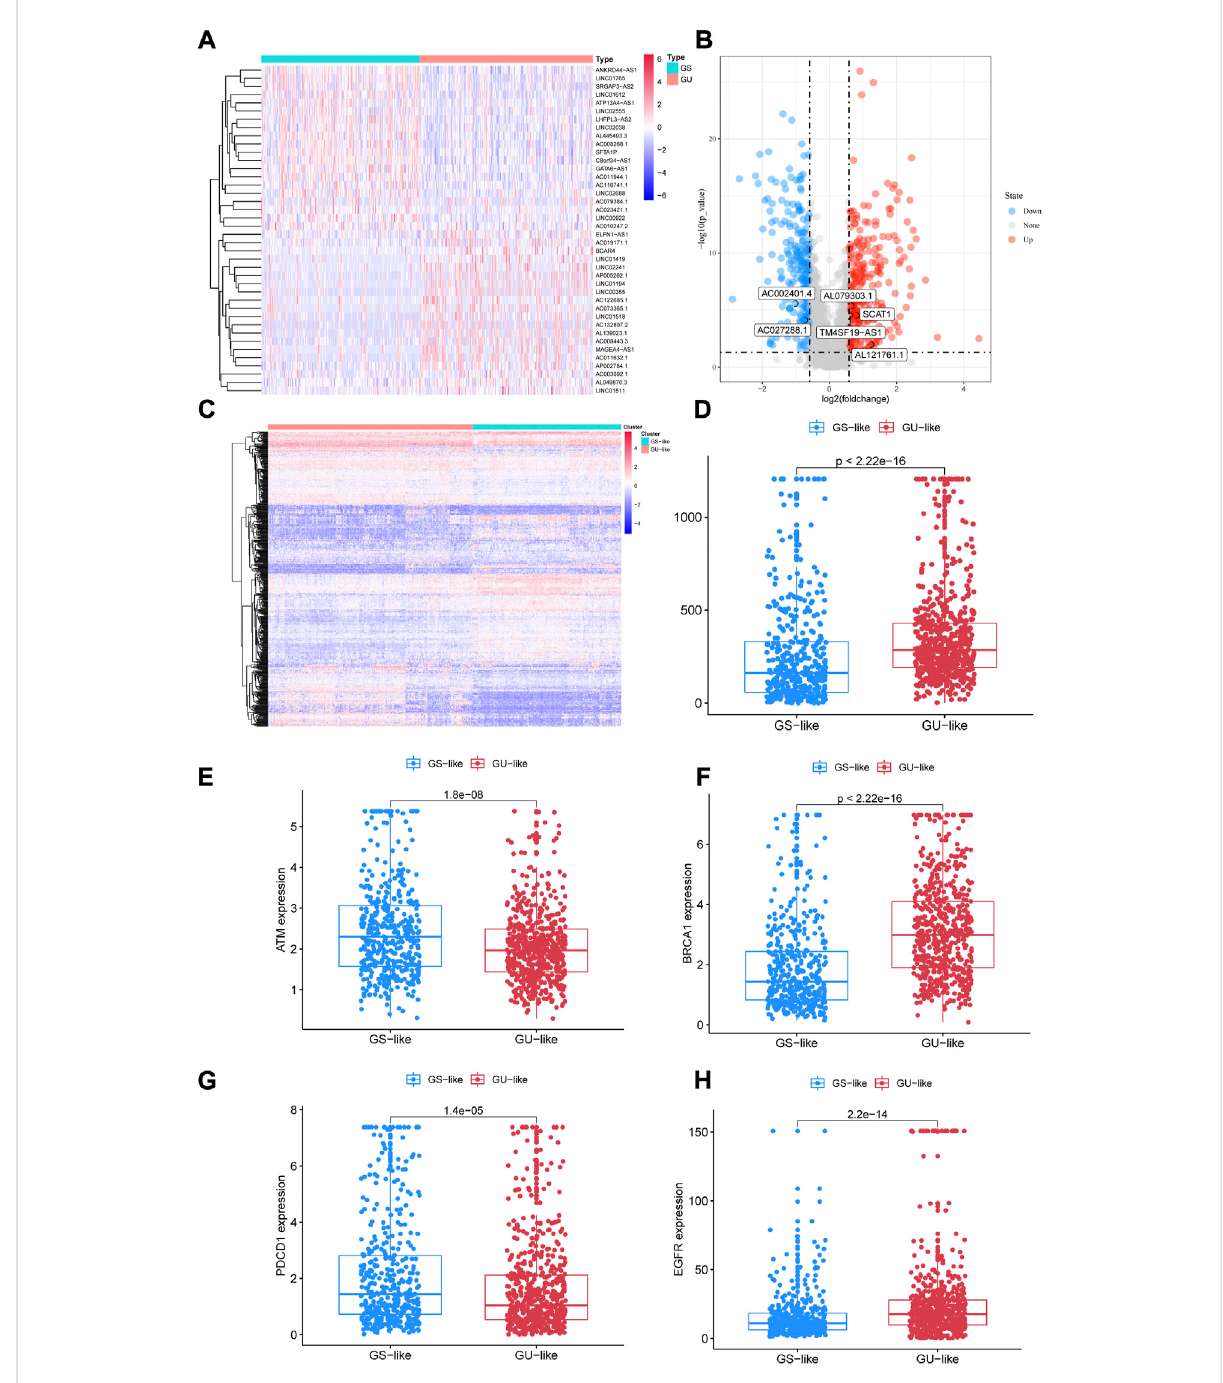
FIGURE 3 Identi fi cationoflncRNAsassociatedwithgenomicinstabilityinNSCLC. (A) DifferentialASeventsbetweenGULandGSLgroups. (B) Volcanoplot of 496 lncRNAs. (C) Heatmap of unsupervised hierarchical clustering analyses of 997 NSCLC patients. Red dots represent GUL clusters, blue dots representGSLclusters. (D) ThefrequencyofsomaticcumulativemutationsinGULandGSLgroup. (E – H) ATM,BRCA1,PDCD1,andEGFRexpression between the GSL group and GUL group. AS, alternative splicing; GUL, genomically unstable-like; GSL, genomically stable-like; GIrLncRNAs, genome instability-related